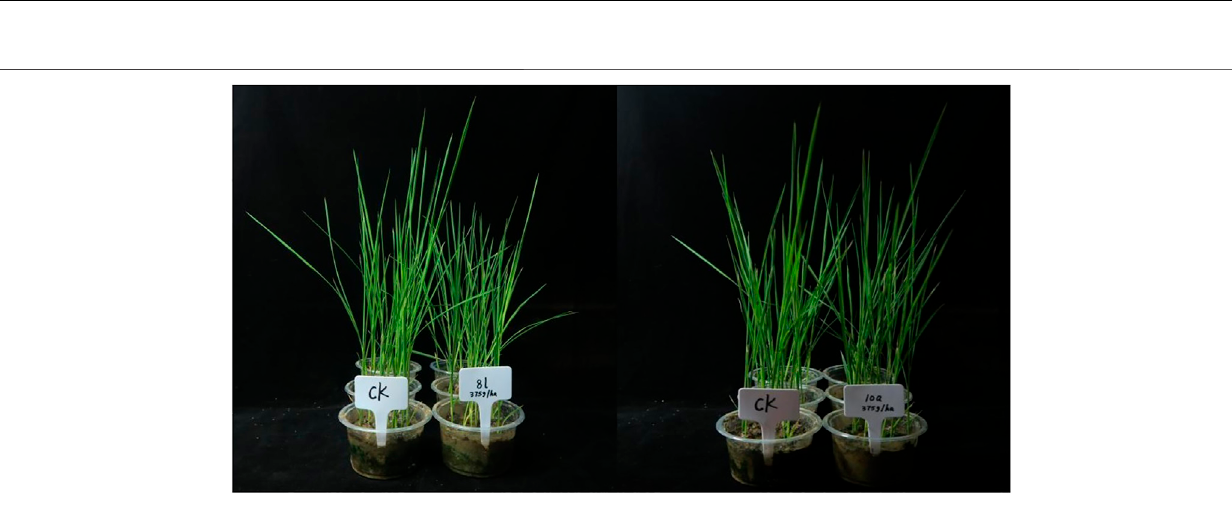
( Table 1 ). At a concentration of 375 g a.i./ha, four of the target compounds (8l, 9h, 9i, and 10a) had the same effect as quinclorac on controlling barnyard grass. In addition, compounds 8l could